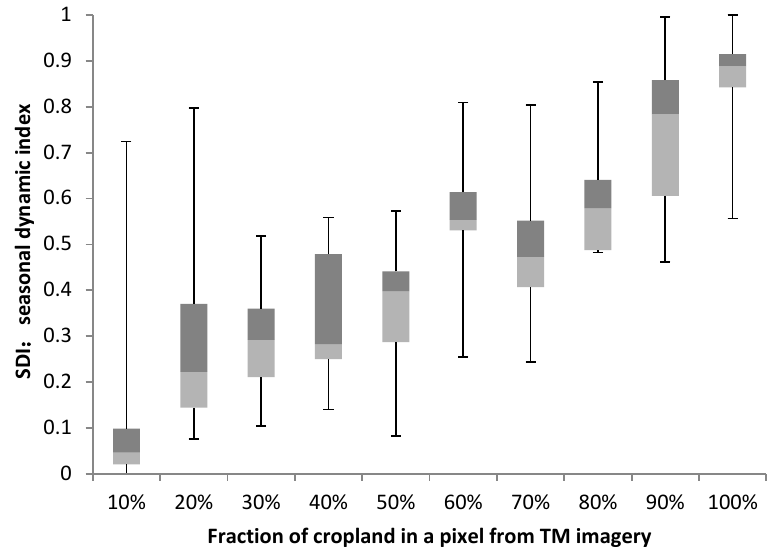
Figure 5. The relationship between seasonal dynamic index (SDI) and fractional croplands.